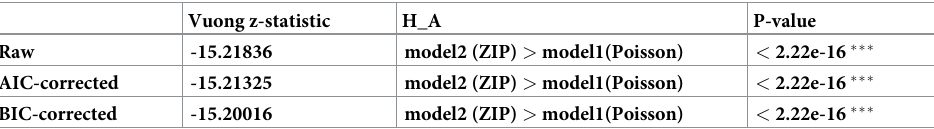
Table 4. Vuong Non-Nested Hypothesis Test-Statistic: comparison of ZIP model against the standard Poisson model. This Test-statistic is asymptotically distributed N(0,1) under the null that the models are